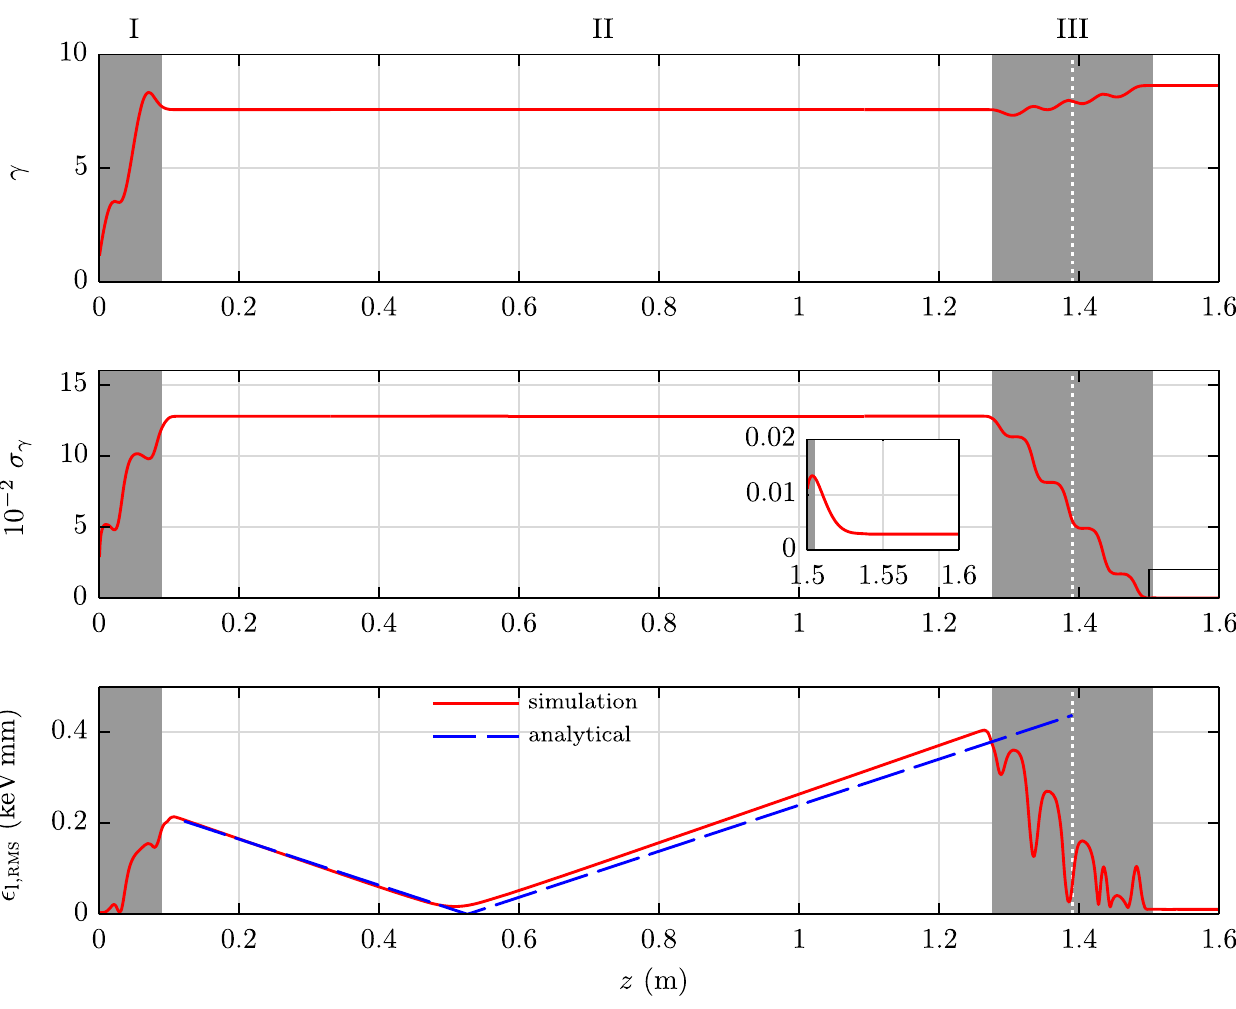
FIG. 13. Evolution of energy γ , RMS energy spread σ γ and longitudinal RMS emittance ϵ 1 compensation parameters discussed in the text and Fig. 12. Due to the change in sign in the second order correlation, indicated by the local minimum of the emittance between the cavities, the energy spread compensation is achieved on an accelerating phase, meaning that the overall energy, γ , is increasing in the second cavity, while σ γ almost